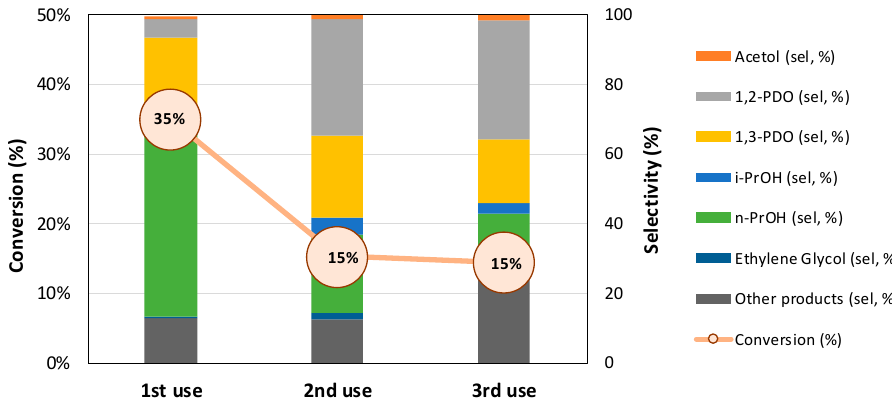
Figure 9. Reusability tests for the Pt//W/ZrO 2 catalyst in the liquid-phase glycerol hydrogenolysis under the following reaction conditions: reaction temperature, 180 °C; H 2 initial pressure, 6 bars; reaction time, 24 h; catalyst, 100 mg; aqueous glycerol 1.36 M (10 mL).